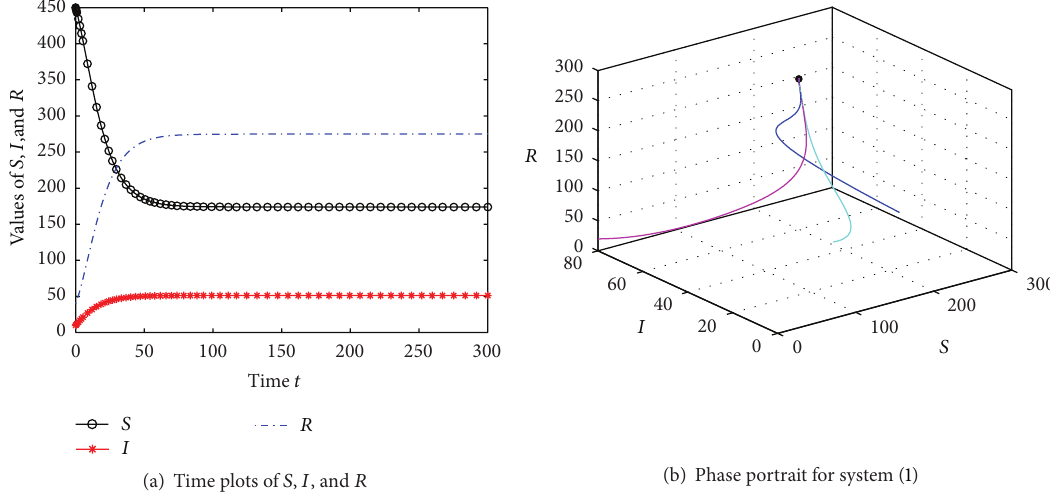
Figure 3: An illustration of the dynamics of system (1) given in Example